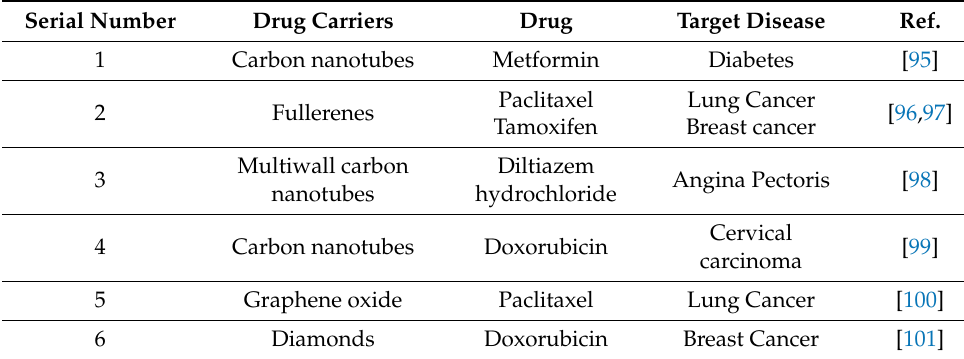
Figure 9. A schematic diagram presenting several strategies for CNT-based drug delivery and cancer therapies. Table 2. Some drug delivery systems based on CNMs with efficacy studies, with specific drugs and target